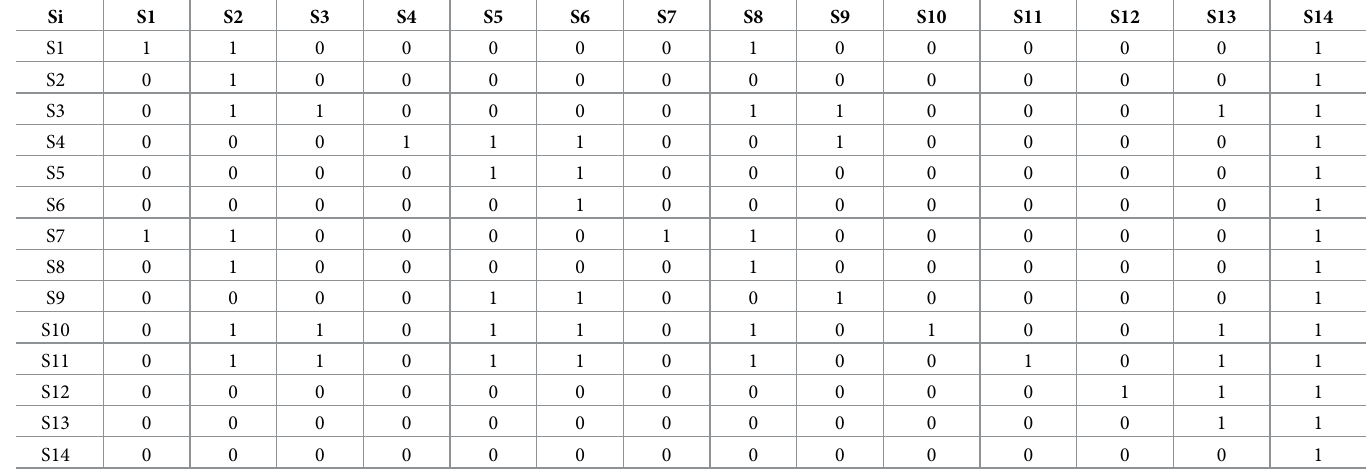
Table 6. The reachability matrix M